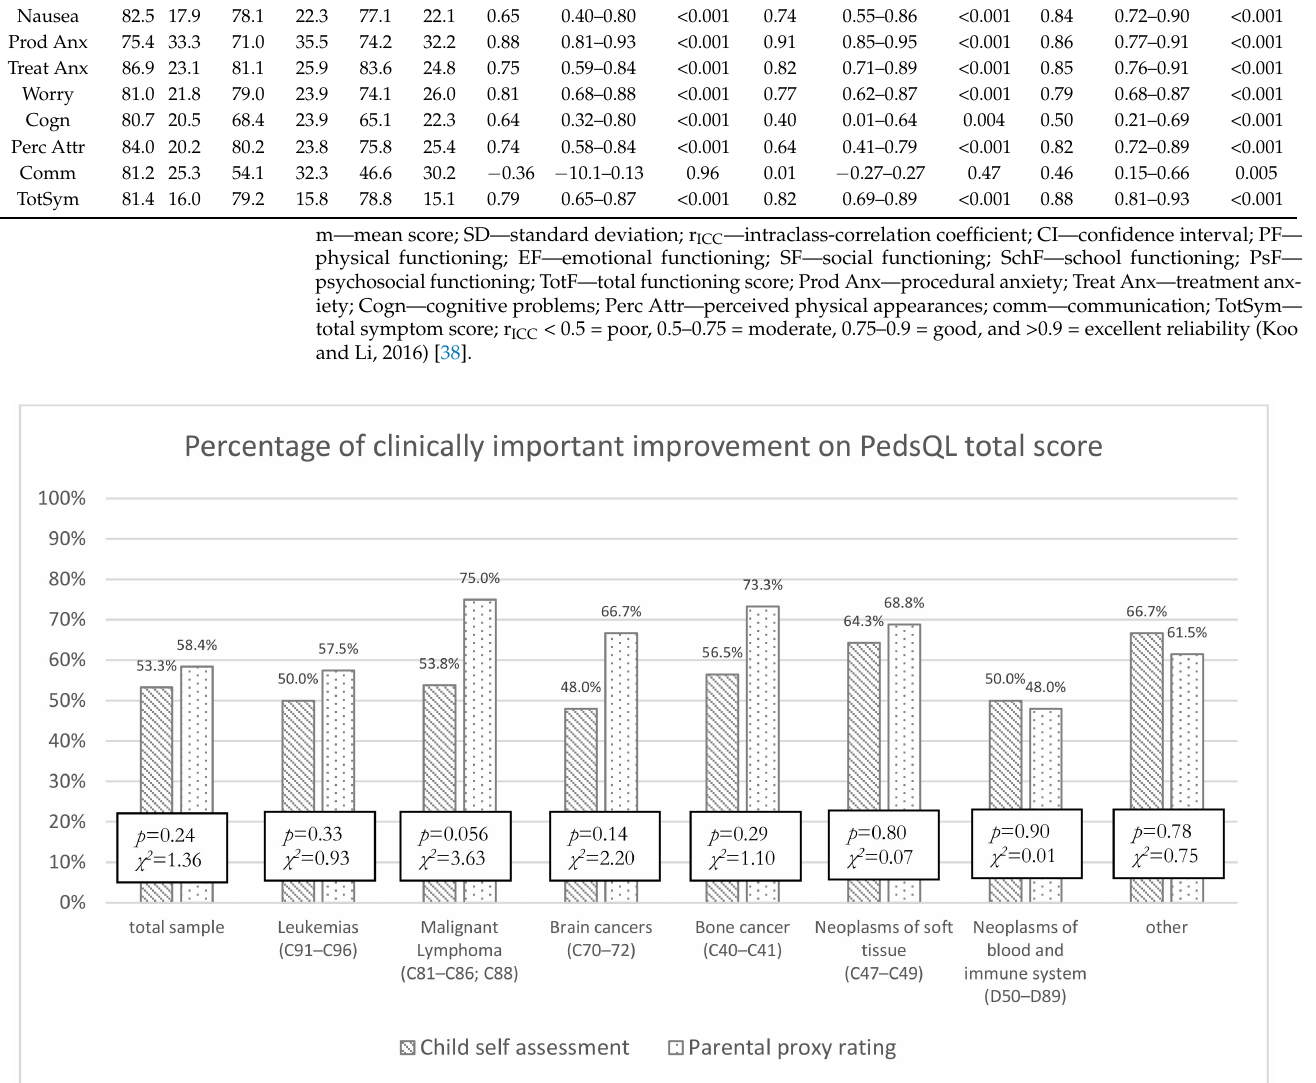
Figure 1. Percentage of patients with clinically relevant improvement based on the PedsQL total score presented for each cancer entity for patient self-report and proxy